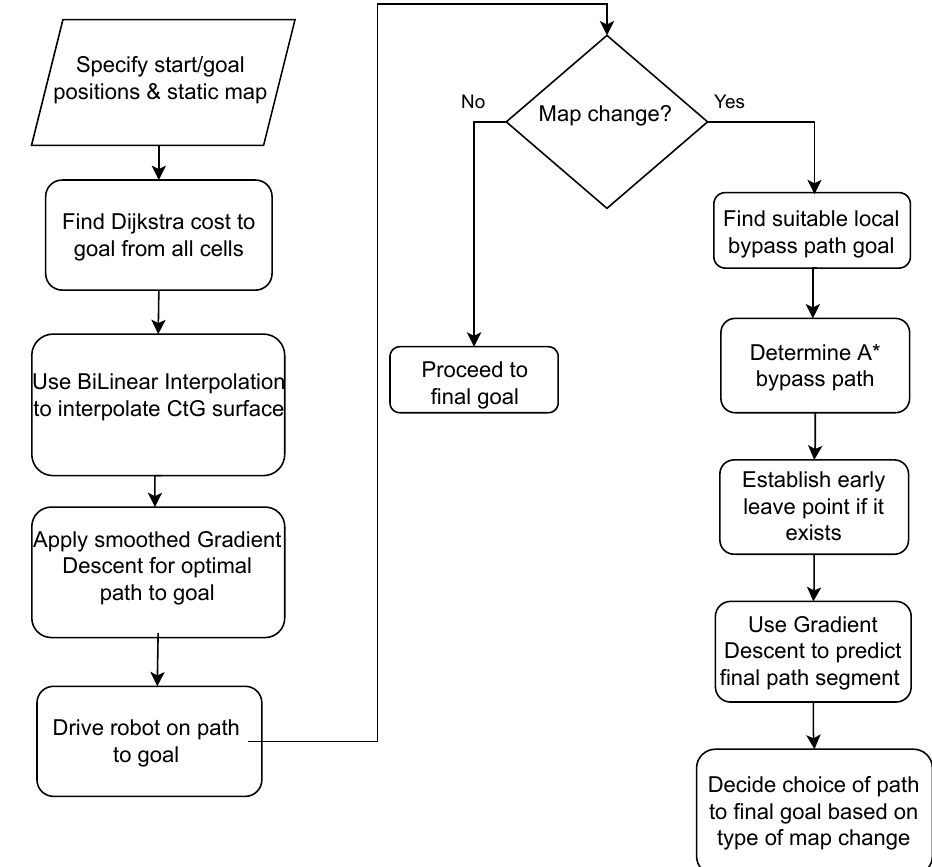
Figure 5. Core flowchart of algorithm (some variations based on case). Leave point determination applies only when current path is